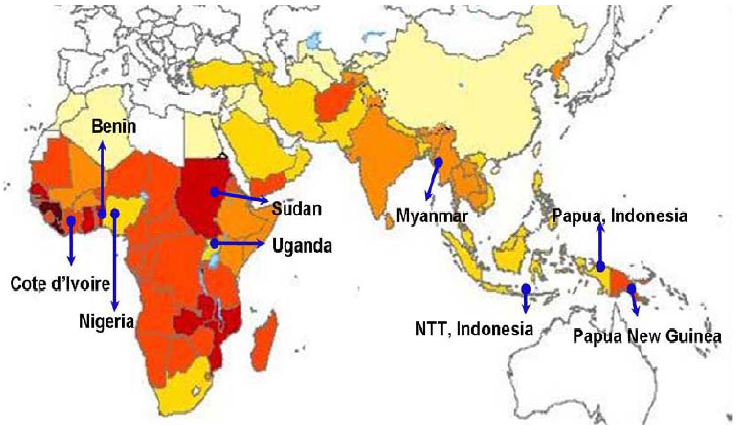
Figure 2. World map indicating countries where ARCO ® studies were